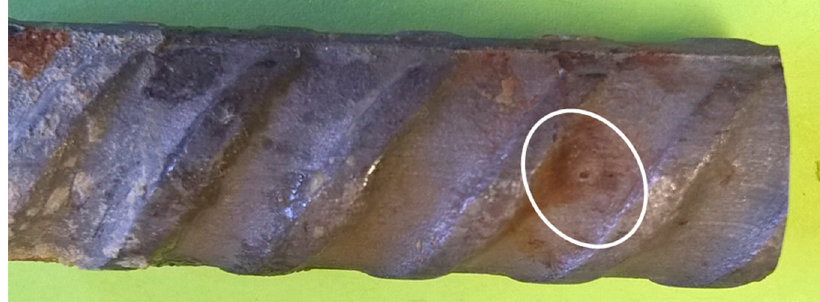
Figure 11. Example of visually detectable pits observed on the surface of tested steels.